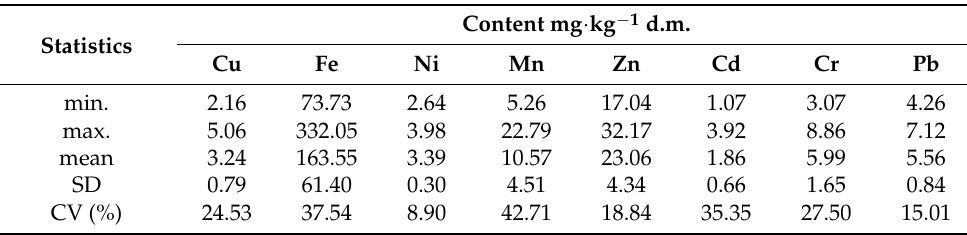
Table 12. The content of heavy metals in the roots of Daucus carota subsp. sativus growing in 24 allotment plots of Gorz ó w Wielkopolski.